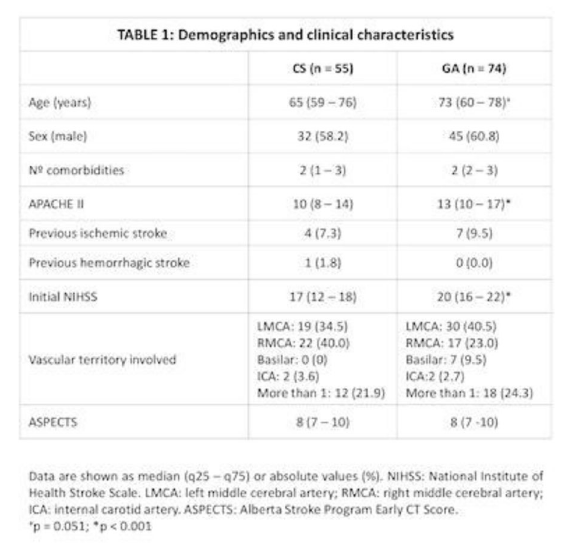
Table 1 (abstract 0035). Demographics and clinical